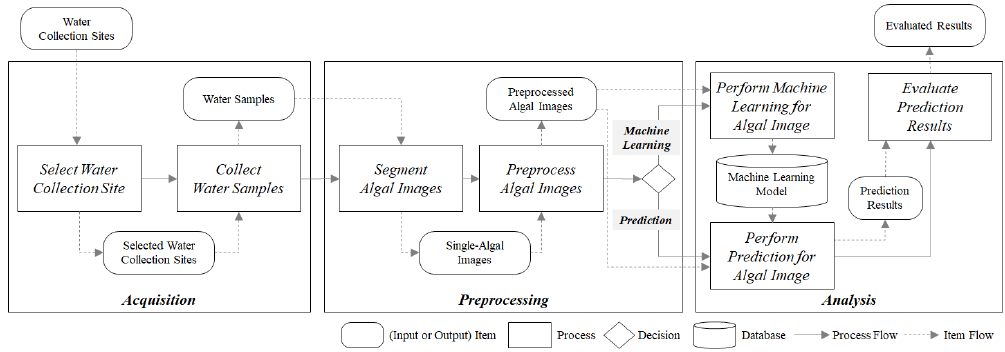
Figure 6. Framework of machine learning analysis for algae